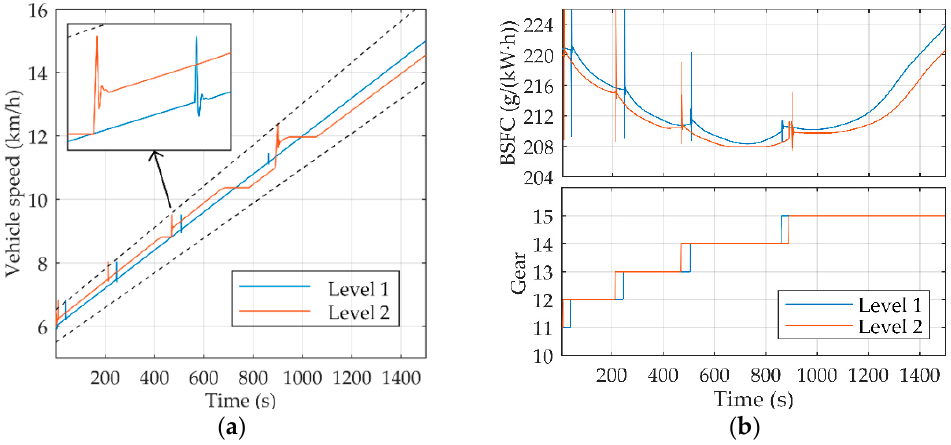
Figure 13. Simulation results of fixed load. ( a ) Speed variations; ( b ) Variations of brake specific fuel consumption and transmission gear.